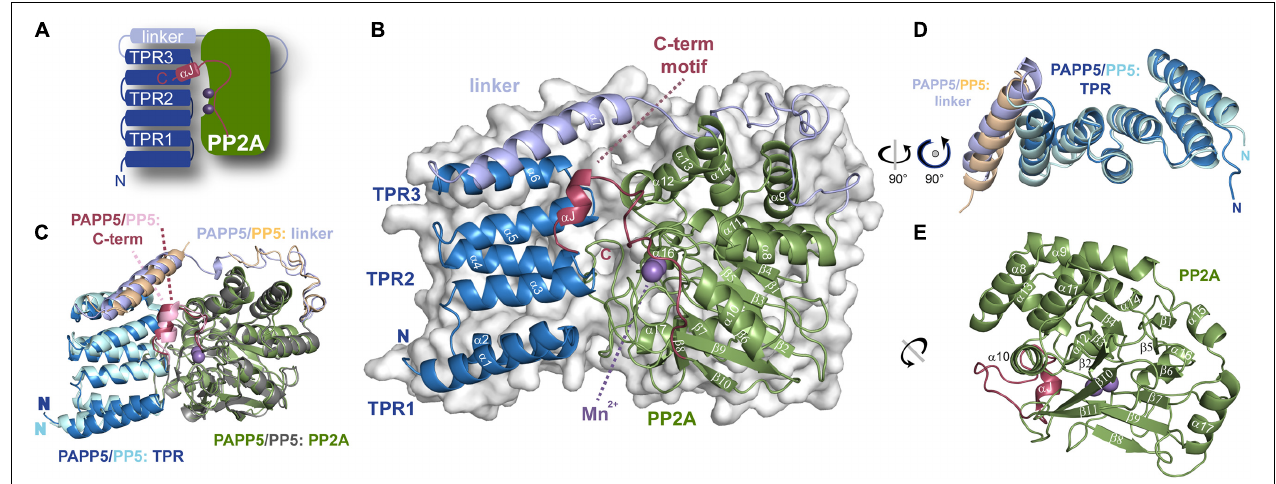
FIGURE 3 | Crystal structure of At PAPP5 phosphatase. (A) Schematic organization of AtPAPP5. (B) The TPR region (blue) is arranged in an α -helical bundle and connected via a long linker region (light blue) to the PP2A domain (green), in whose active site two Mn 2 + ions (purple) are bound. The C-terminal inhibitory motif (raspberry) and the TPR region cover the active site. (C) Superposition of At PAPP5 and Hs PP5 structures (PDB code: 1WAO). (D) After superposition on the central TPR2 repeat, the superposed TPR regions show some deviations for the TPR3 repeat and the linker helix. (E) The catalytic PP2A domain consists of 11 β -strands arranged as a central β -sandwich that is surrounded by α